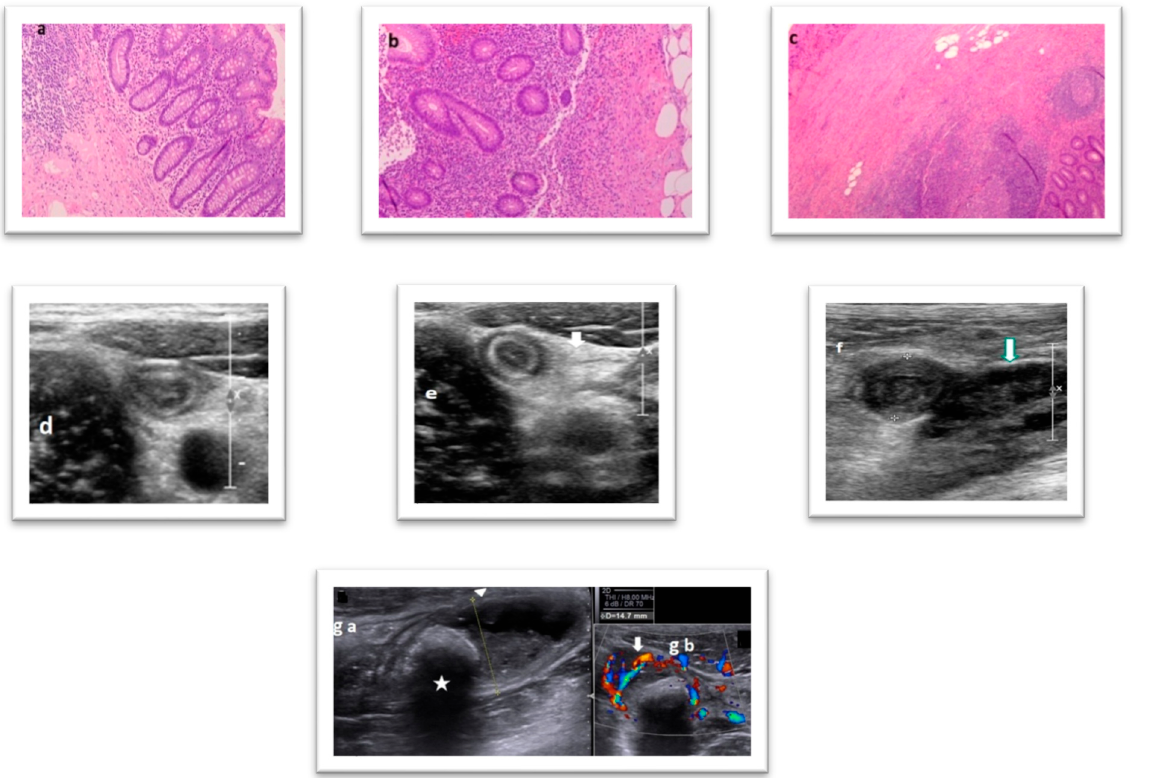
Figure 1. Correlation between US and intraoperative/histopathological findings. ( a ) Normal appendix: minimal changes—mild lymphoplasmacytic infiltration in the mucosa (H&E stain, magnification × 10). ( b ) Acute uncomplicated appendicitis: intense presence of neutrophils (H&E stain, magnification × 10). ( c ) Acute complicated appendicitis without perforation: extensive inflammatory infiltration mainly composed of neutrophils and lymphocytes involving all thickness of the organ’s wall (H&E stain, magnification × 4). ( d ) Normal compressible appendix (note the ovoid shape because of the compression). ( e ) Uncompressible, with “target sign” appendix in axial view. Uncomplicated AA but with increased echogenicity of periappendiceal fat (arrow), which represents an attempt to wall-off the imminent perforation. ( f ) Thickening and ill-defined “target-sign” in the edematous appendix. Periappendiceal hypoechoic fluid collection (arrow) with internal echoes is present [complicated AA]. ( g ) Appendicolith with acoustic shadow [star-( ga )] obstructing the appendiceal lumen (diameter approximately 15 mm). Periappendiceal fat and mural hypervascularity is present [arrow in ( gb )] and obliteration of wall layer structure indicates a high chance for perfo-